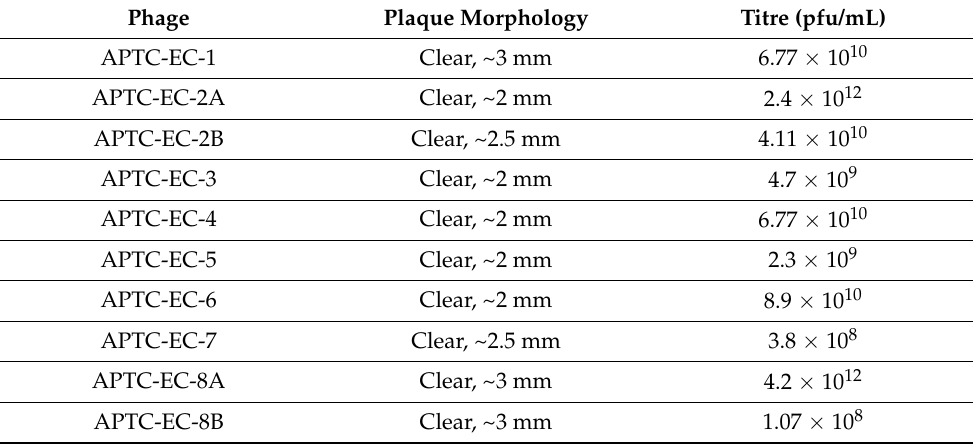
Table 3. Morphological Characteristics of Isolated Phages.